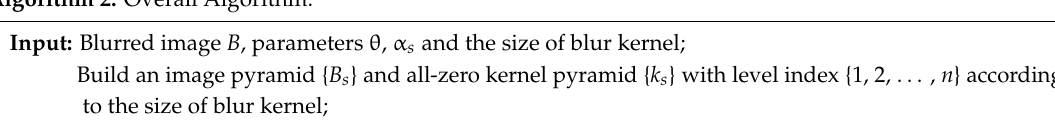
Algorithm 2. Overall Algorithm.